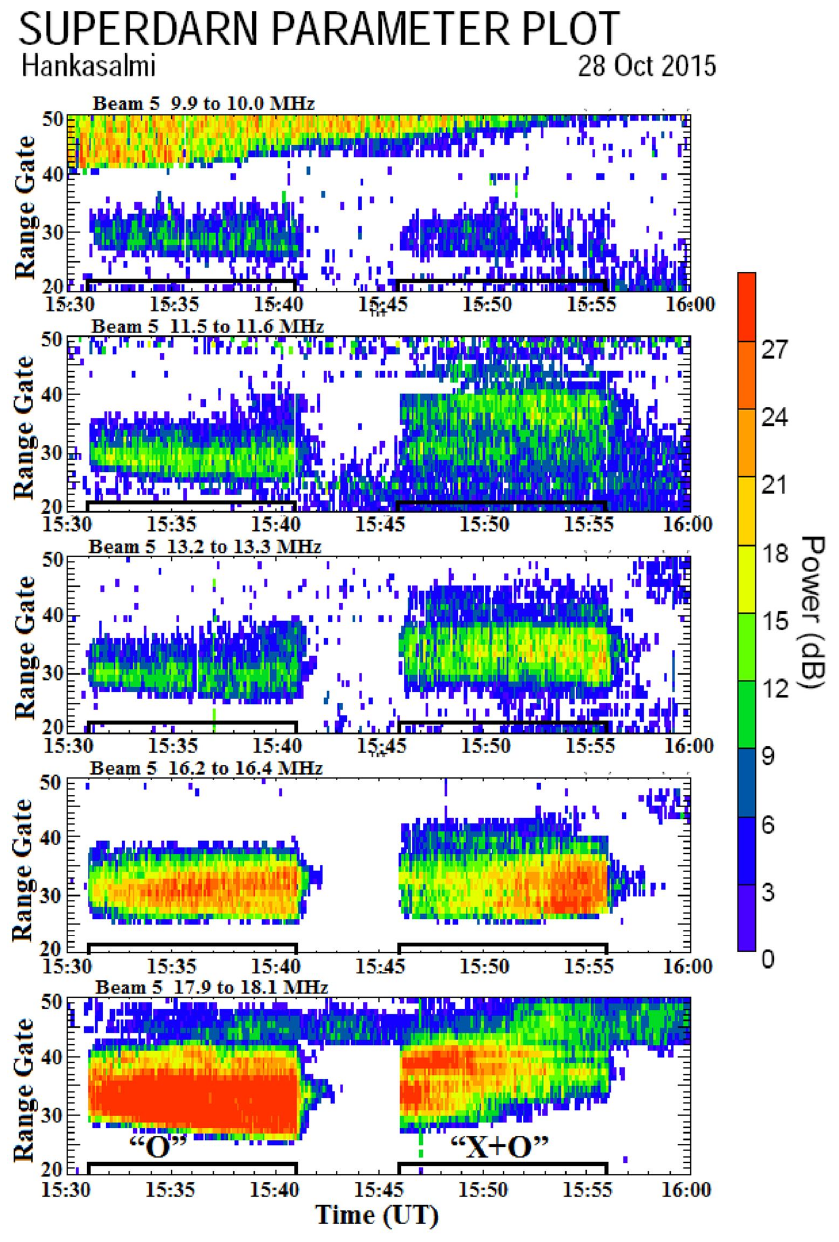
Figure 6. The backscatter power from CUTLASS Hankasalmi (Finland) radar observations (beam 5) at operational frequencies about of 10, 11.5, 13.2, 16, 18 MHz in range gate—time coordinates on 28 October 2015 from 15:30 to 16:00UT. The distance from Hankasalmi to the heated ionospheric path over Tromsø corresponds to range gates 30–35.